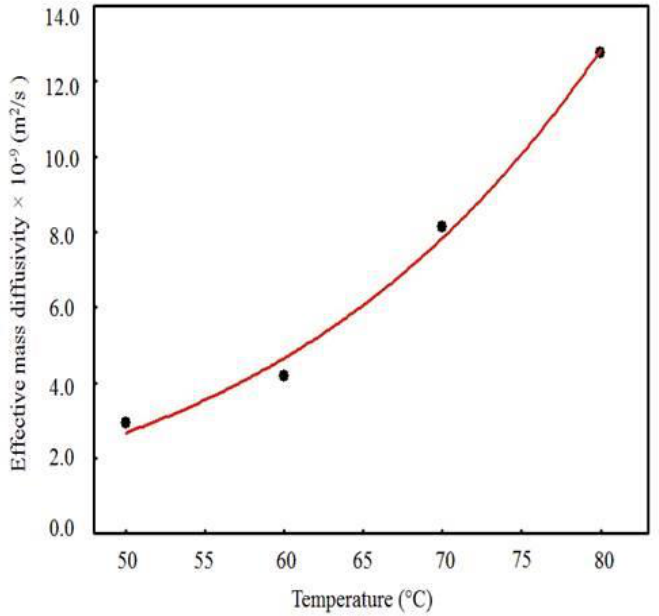
Figure 6. Effective mass diffusivity versus drying air temperature.